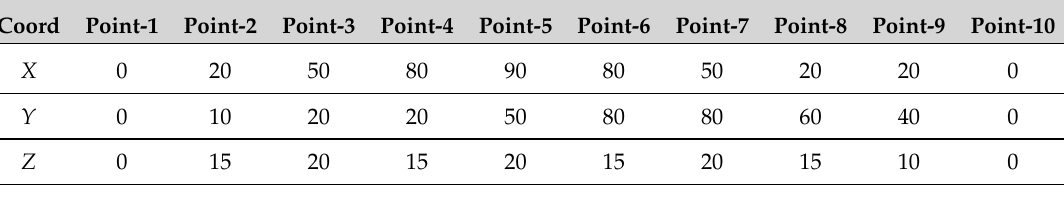
Table 2. 3D coordinate of turn points in Figure 10a.